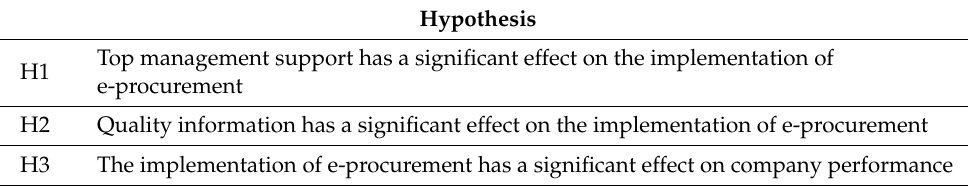
Table 1. Hypotheses regarding the relationship of e-procurement implementation to company performance.